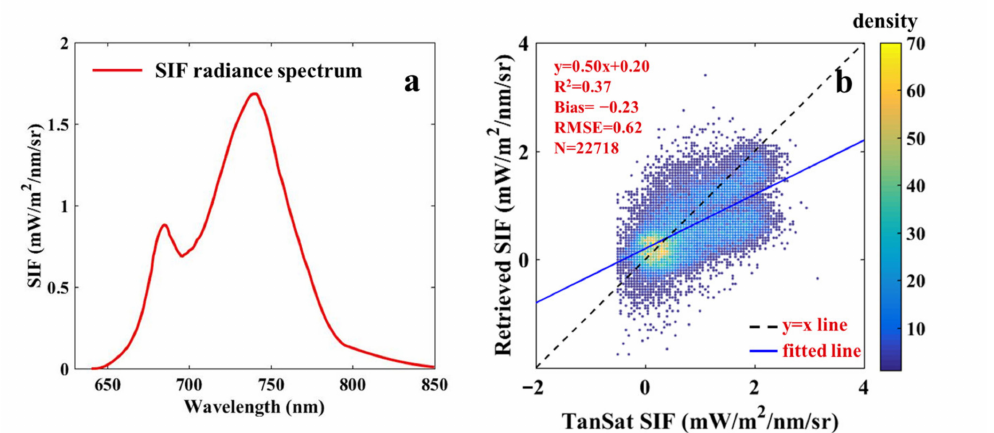
Figure 3. ( a ) SIF spectral distribution from SCOPE, ( b ) scatter plot of SIF retrievals and TanSat SIF. The color legend indicates the density of scattered points.